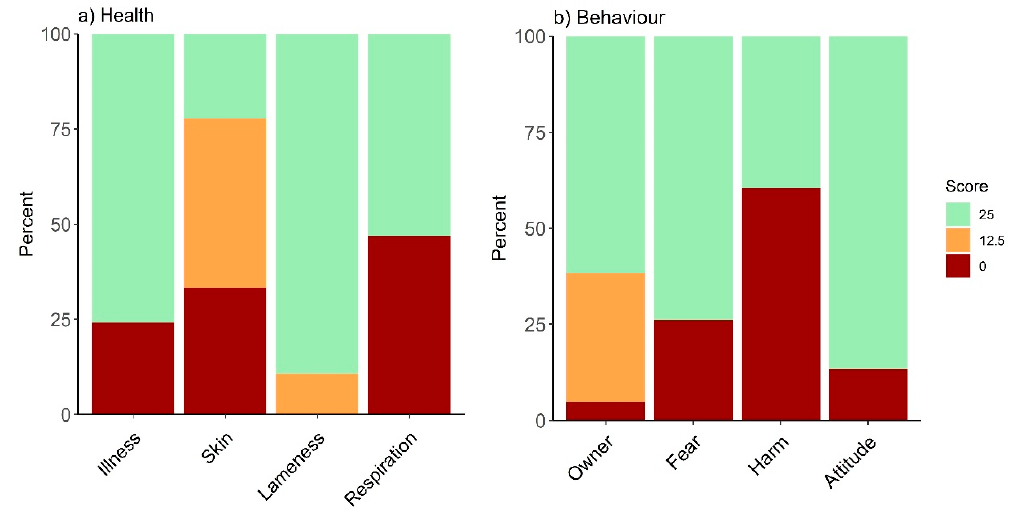
Figure 3. Percentage of responses obtaining each of the available scores per question for the ( a ) health and ( b ) behavior decision trees for Pakistan.